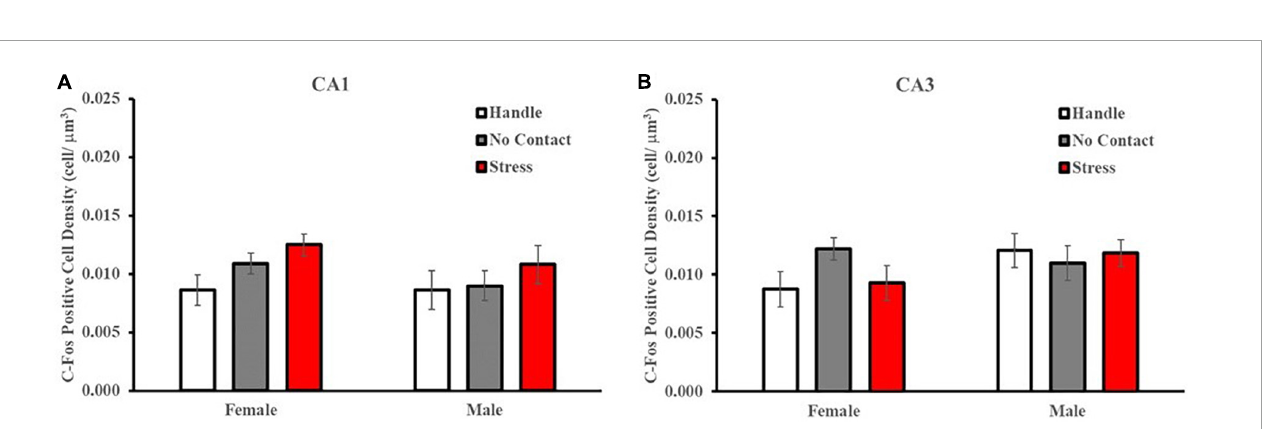
FIGURE9 Preadolescent exposure condition does not alter c-Fos labeling in the CA1 or CA3 region of the hippocampus. c-Fos positive cell density within the dorsal CA1 and CA3 regions across conditions (M ± SEM). There were no differences detected in c-Fos labeling patterns in the CA1 (A) nor CA3 (B) regions based on group